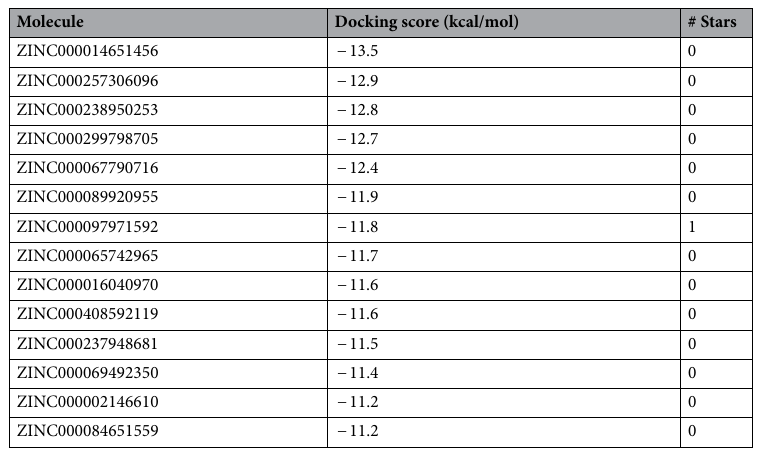
Table 2. Summary of docking results and pharmacokinetic information of the top 14 ZINC candidates. Docking score is empirically calculated in kcal/mol from rigid receptor GlideHTVS protocols which help define compounds with good binding affinity. The scoring function is comprised of lipophilic, hydrogen bonding, hydrophobic terms as well as a rotable bond penalty. The #stars is a parameter defined by QikProp module and scores compounds based on their similarity to known